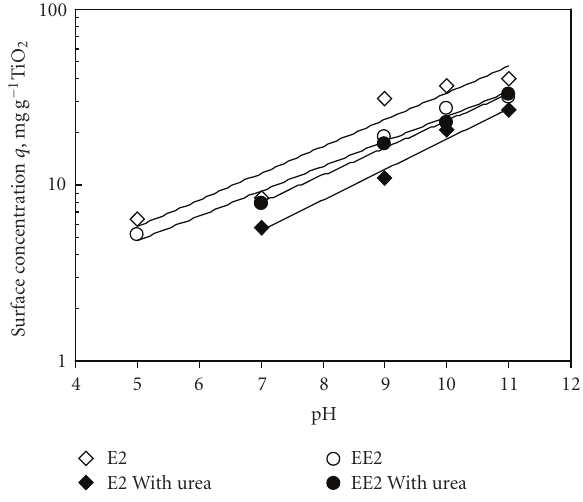
Figure 4: The SEs equilibrium surface concentrations on TiO 2 ver- sus pH with and without the presence of urea (75mg L − 1